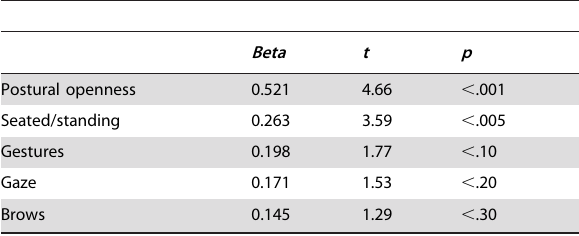
Table 5. Relative role of status cues in affecting